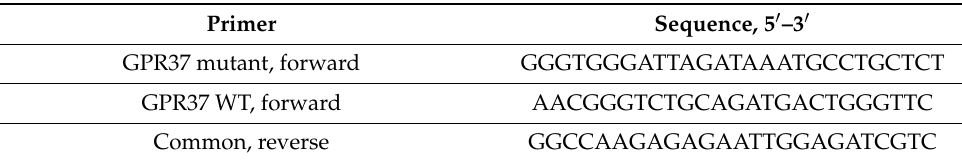
Table 2. Primers used for GPR37